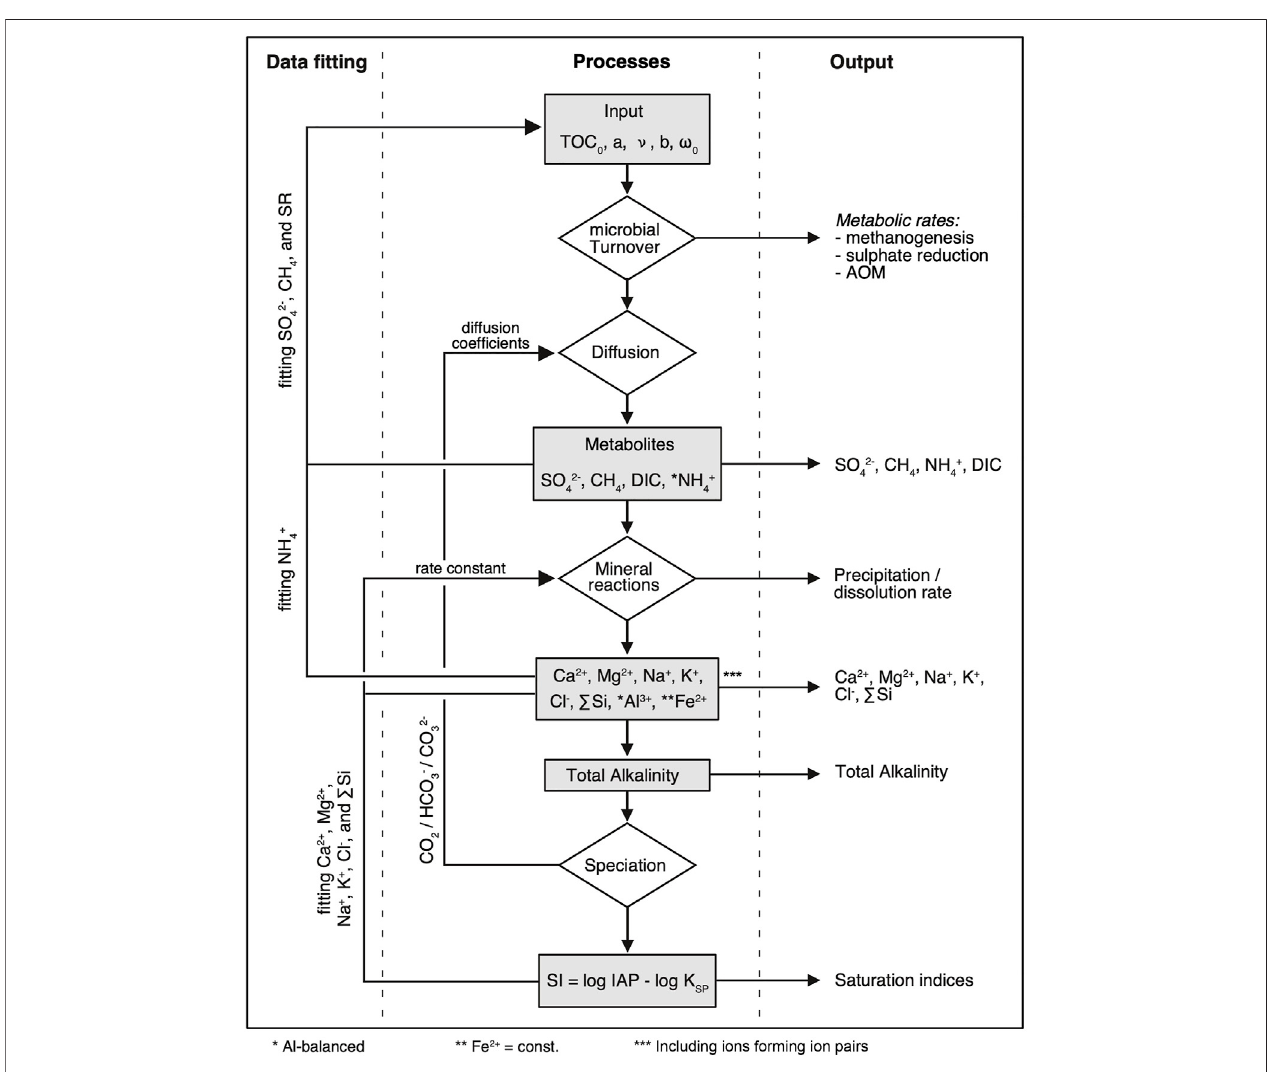
FIGURE 2 | Flow chart representation of the basic reaction-transport and precipitation model, including feedbacks, data fi tting, and output. TOC 0 is the initial total organic carbon content (wt%) at the time of sediment deposition. The parameters a and ν describe the function of organic matter degradation according to Boudreau and Ruddick (1991), ω is the sedimentation rate after compaction, and b de fi nes the compaction with depth. AOM (cid:1) anaerobic oxidation of methane.